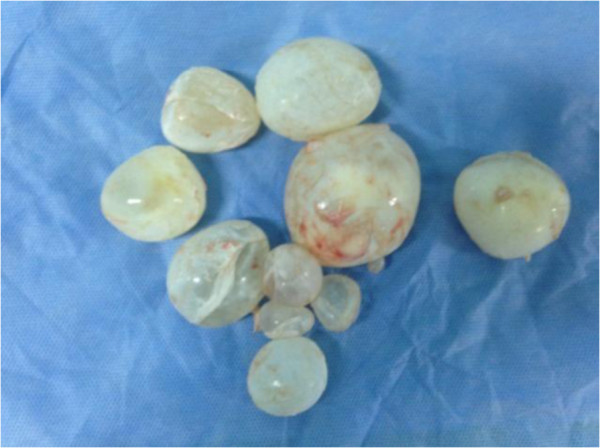
Daughter vesicles.